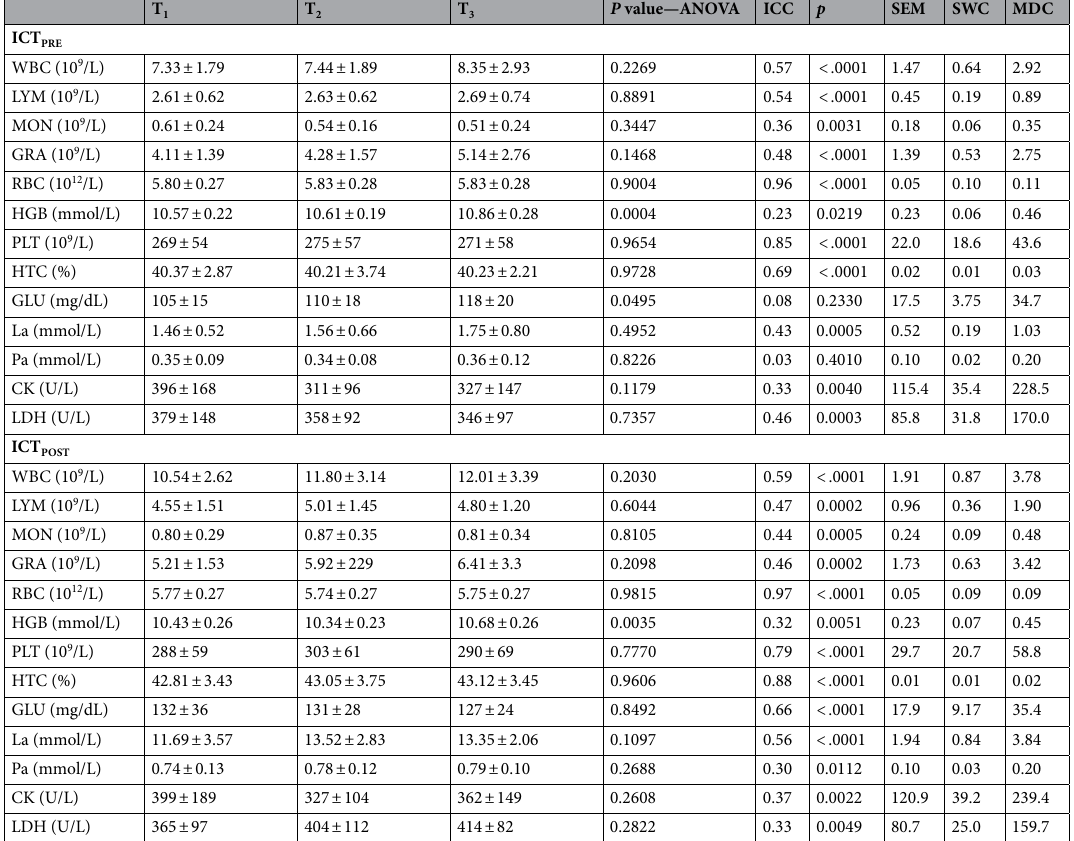
Table 7. Repeatability of hematological and biochemical parameters measured before and after incremental cycling test. CK, creatine kinase; GLU, glucose; GRA, granulocytes; HGB, hemoglobin; HTC, hematocrit; ICC, interclass correlation coefficient; ICT POST , after incremental cycling test; ICT PRE , before incremental cycling test; La, lactate; LDH, lactate dehydrogenase; LYM, lymphocytes; MON, monocytes; MDC, minimal detectable change; Pa, pyruvate; PLT, platelets; RBC, red blood cells; SEM, standard error of measurement; SWC, smallest worthwhile change; WBC, white blood cells.